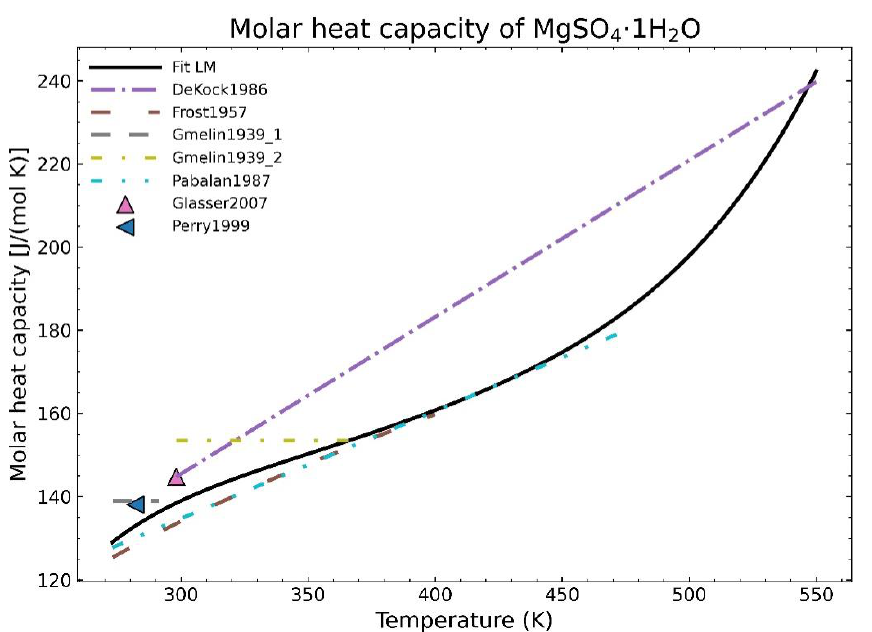
Figure 1. Fitting of the heat capacity for the substance MgSO 4 · 1H 2 O using the Levenberg-Marquardt algorithm.